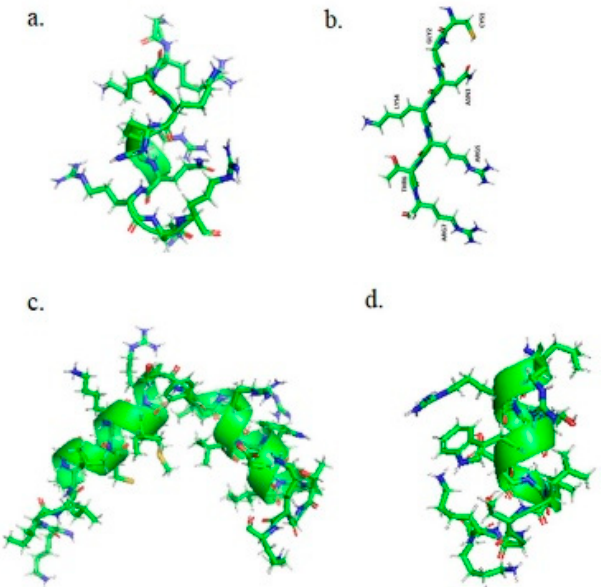
Figure 1. Secondary structure of the peptides used in this study, generated with pyMol 2.1. ( a ) TAT peptide, ( b ) tLyP-1 peptide, ( c ) NKCS peptide, ( d ) NKCS-[15-27]